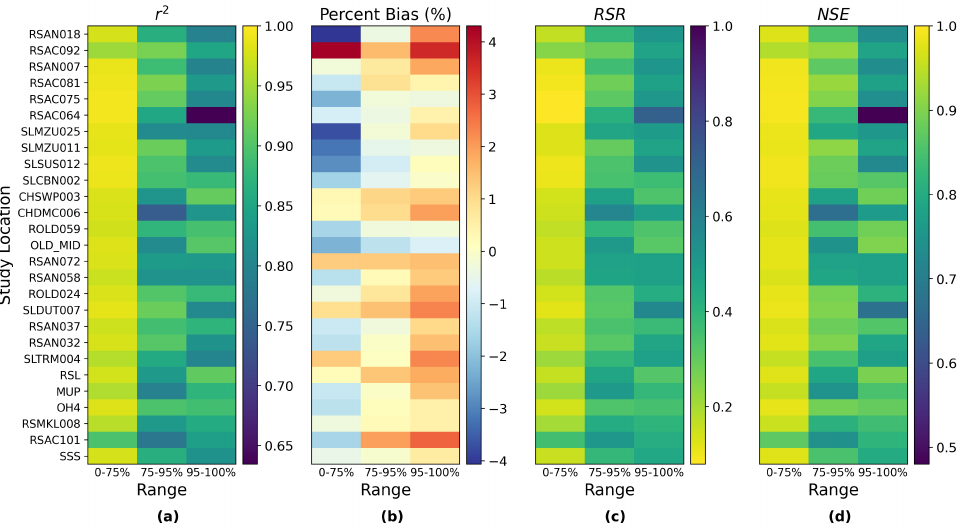
Figure 9. Model (grouped LSTM) performance measured by ( a ) r 2 , ( b ) Percent Bias, ( c ) RSR, and ( d ) NSE at different salinity ranges: low-middle range (lowest 75%), high range (75 to 95 percentile, and extremely high range (highest 5%) at the study